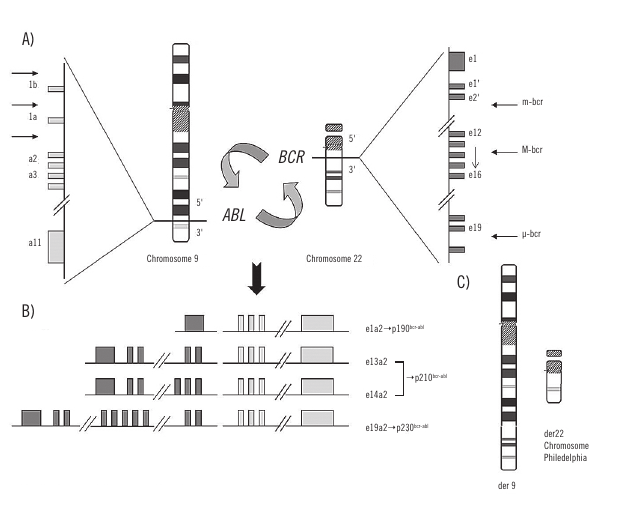
FigurE − Translocation in the BCR-ABL1 gene A) ABL: located on the long arm of chromosome 9. Its breakpoints are variable and can occur upstream of the first alternative exon 1b, downstream of the second alternative exon 1a, and between both (left arrows). BCR: located on the long arm of chromosome 22, which has three breakpoints: m-bcr, M-bcr and μ-bcr; B) the fused messenger RNA molecules e1a2, e13a2, e14a2 and e19a2 exons junctions ( ABL exons in light grey and BCR exons in dark grey) and their respective generated chimeric proteins (p190, p210 and p230); C) reciprocal translocation between chromosomes 9 and 22 with the derived chromosomes. BCR: breakpoint cluster region; ABL: Abelson proto-oncogene; m-bcr: minor breakpoint cluster region; M-bcr: major breakpoint cluster region; μ-bcr: micro breakpoint cluster region; RNA: ribonucleic